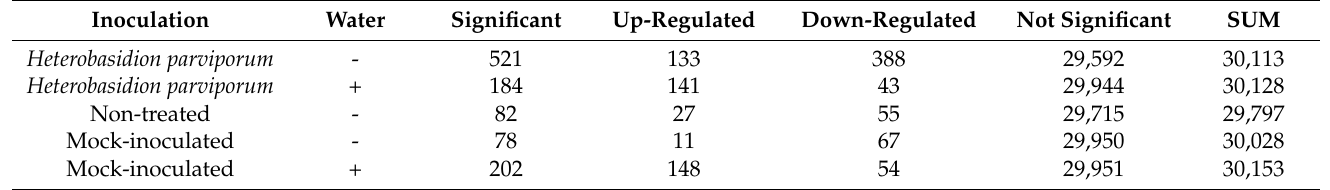
Table 1. Statistically Differentially Expressed Genes of Each Treatment When Compared to Non-treated (+) Water Group.